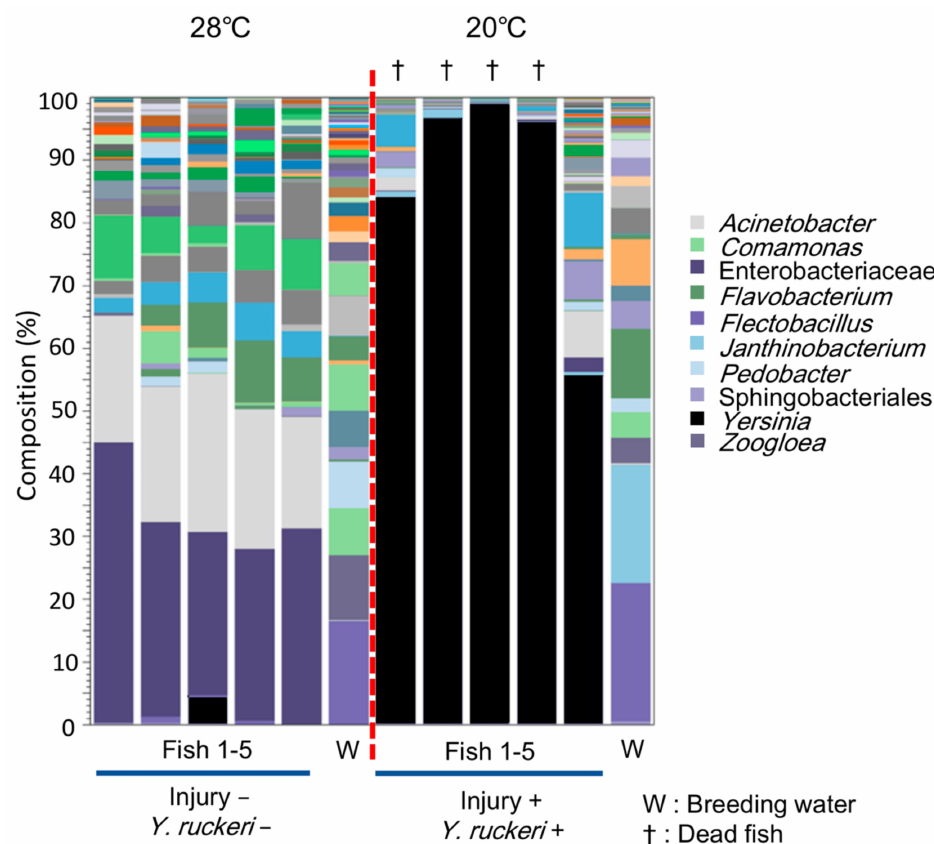
Figure 3. Composition of skin bacterial floras from zebrafish under normal breeding conditions and under infectious conditions. The stacked bar chart shows the composition operational taxonomic units (OTUs, top 50) in the fish skin bacterial flora above the genus level. The bars to the left and right of the red dot line represent data collected under normal breeding conditions and infectious conditions,